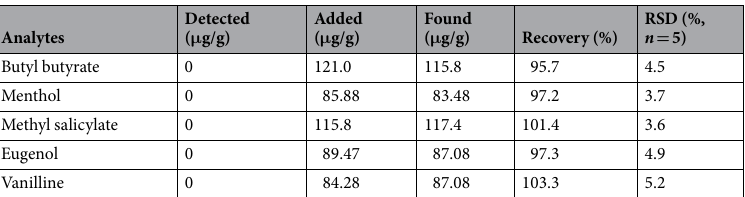
Table 5. Detection of five flavor agents in chewing gum without any volatile flavor compounds.